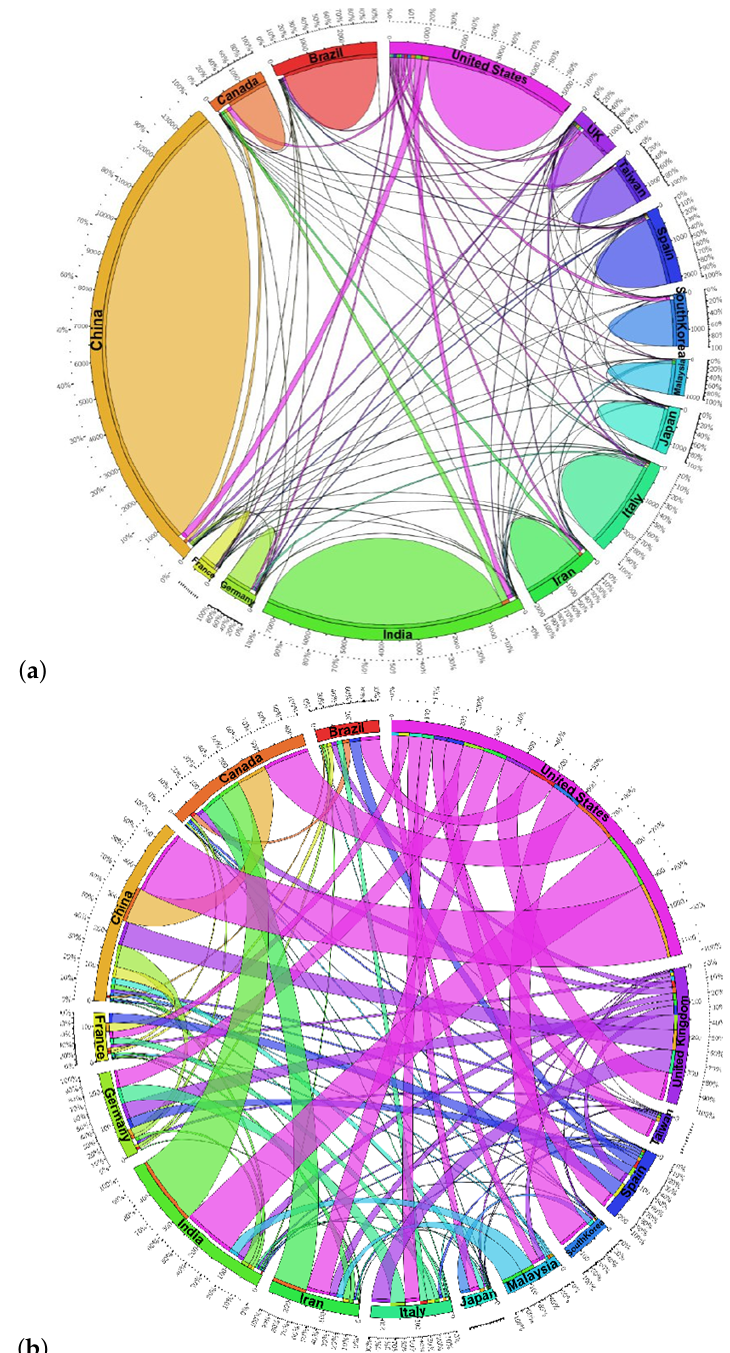
Figure 6. (a) local and international collaborations in power quality; (b) international collaborations in power